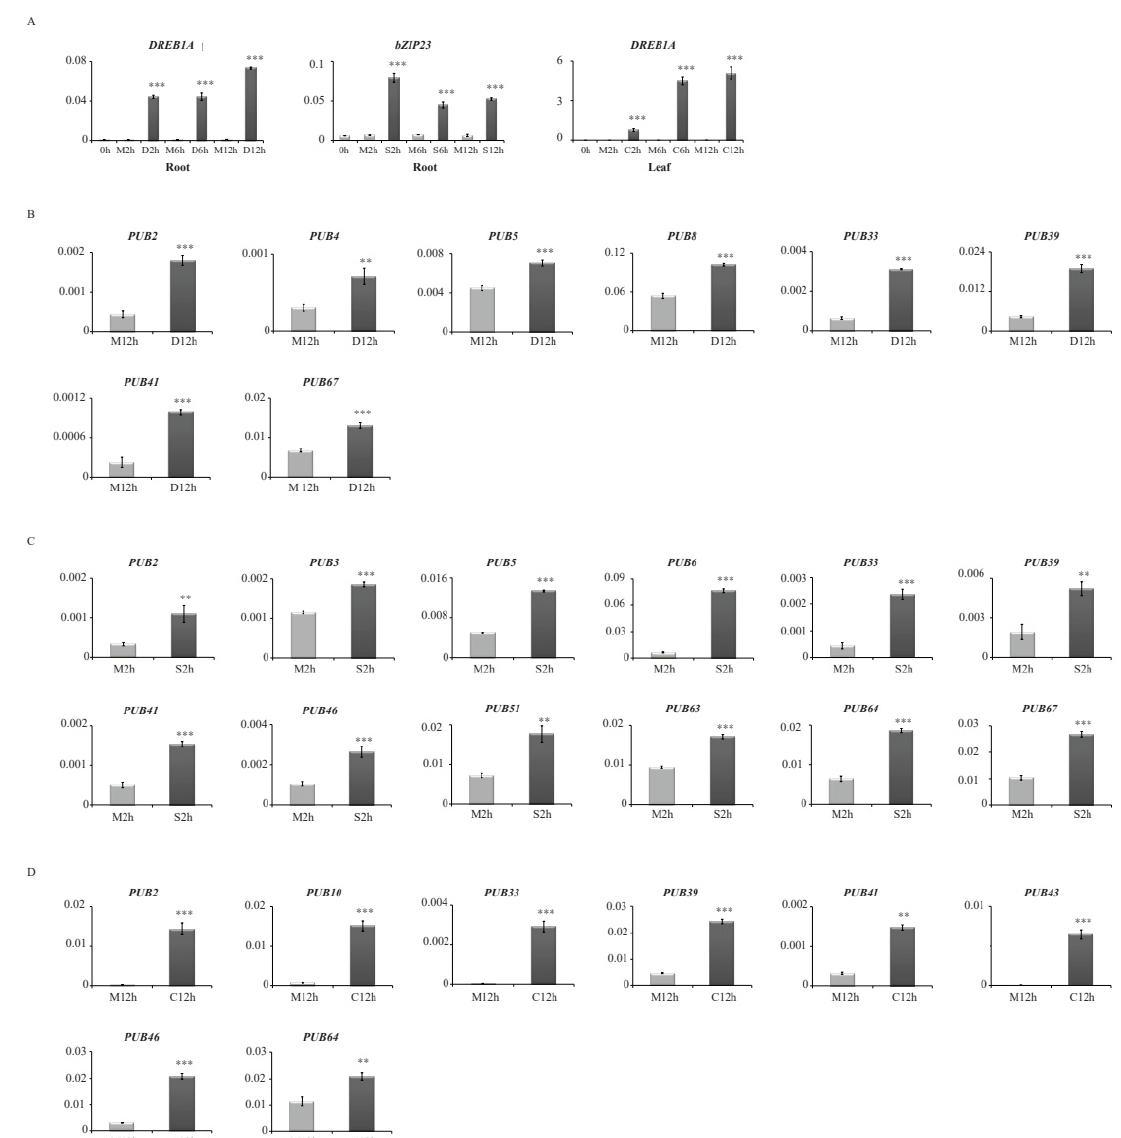
Figure 2. qRT expression profiles for 16 OsPUB genes selected from global transcriptome data analysis. OsDREB1A and OsbZIP23 were used as marker genes for abiotic stress ( A ). Abiotic stress samples were prepared from drought ( B ), salinity ( C ), and cold ( D ) (0, 2, 6, and 12 h) in root or leaf. Rice ubiquitin ( OsUbi5 ) was served as internal control. ** p value < 0.01; *** p value < 0.001. N = 3.